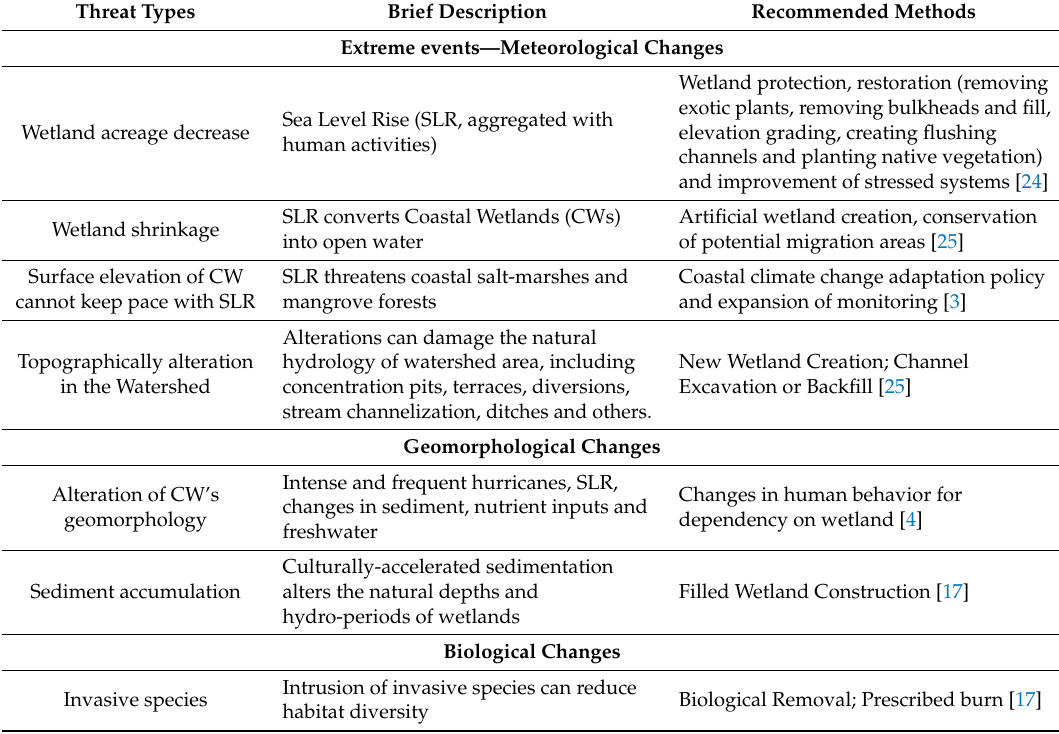
Table 1. Summary of Threats in Coastal Wetlands and Recommended Actions for